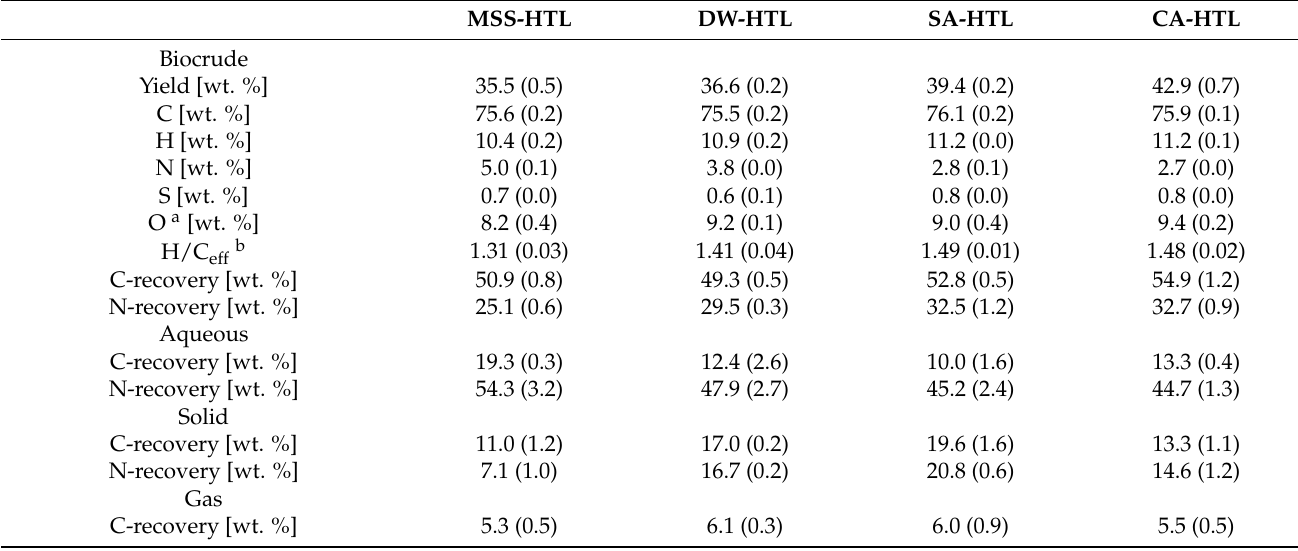
Table 2. Characterization of HTL products. Yield is based on dry, ash free values. The values in brackets indicate the standard